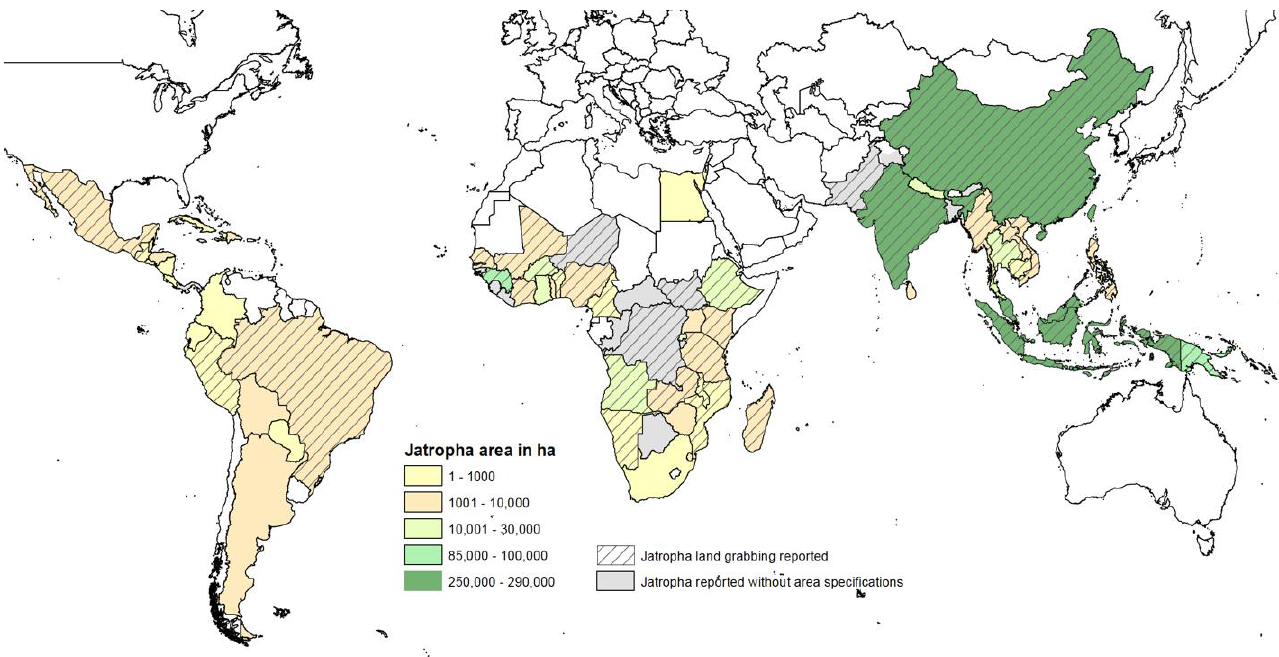
Figure 2. Global jatropha area estimates, source: author, area estimates from BioZio [71], Castro Gonzáles [72], GEXSI [63], GRAIN [73], van Eijck et al. [74], Wahl et al. [75], and Walmsley et al. [68]; cases of land grabbing as reported by The Land Matrix [22], (data of 2017).